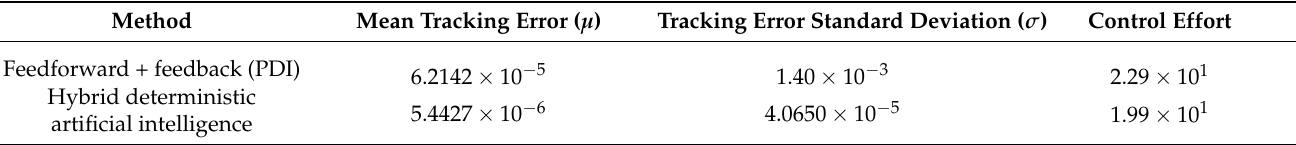
Table 8. Figures of merit for thirty-degree yaw with perturbations and simulated damage 1